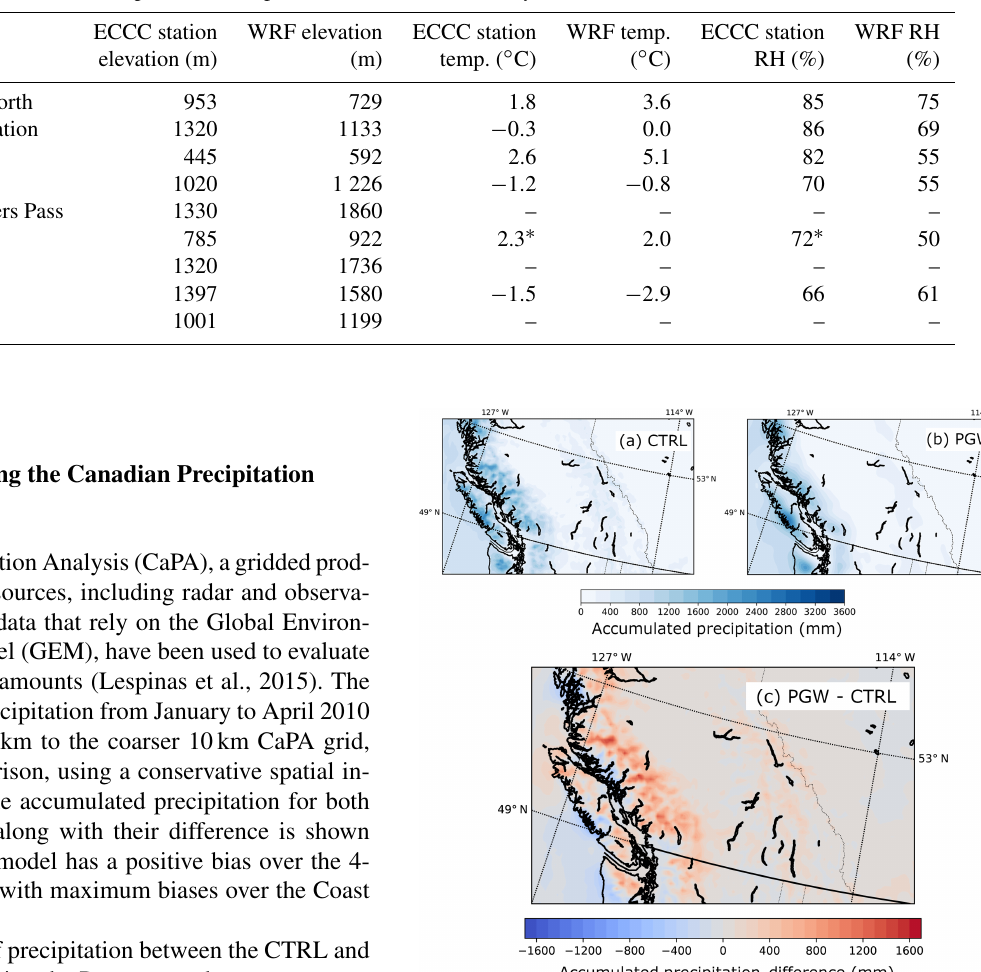
Table 2. ECCC observation stations used for CTRL temperature and relative humidity verification for the January–April 2010 period. Stations are listed from west to east. Meteorological data are averaged over the 4-month period at each ECCC station and at the closest CTRL model grid point. RH refers to relative humidity, and the ∗ symbol refers to information only available from 07:00 to 17:00 local time at Golden. Comparison of temperature and relative humidity at ECCC Stations